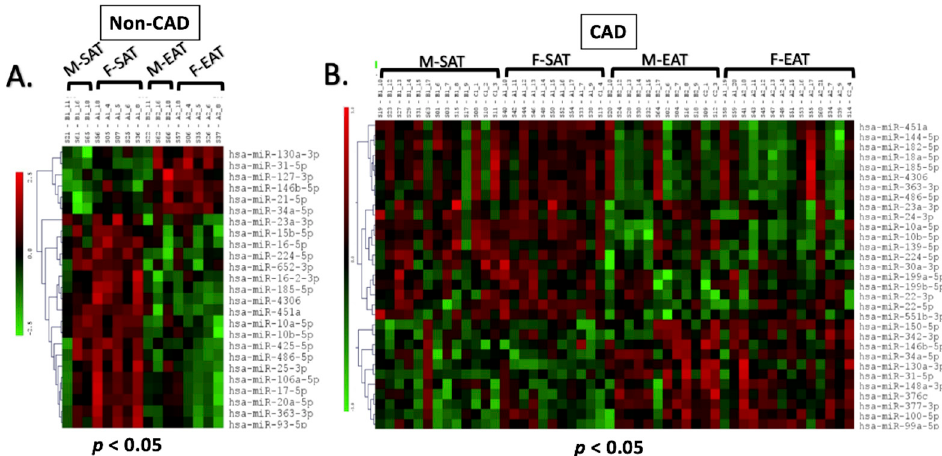
Figure 1. Heatmap of differentially expressed miRNAs between epicardial and subcutaneous adipose tissue samples from patients with and without CAD: microRNA microarray on EAT and SAT samples from both males and females were analyzed and compared. The heatmap (LC Sciences, Houston, TX, USA) displayed shows differentially expressed microRNAs between EAT and SAT in non-CAD patients ( A ) and CAD patients ( B ). Differential analysis was first performed using ANOVA to produce a miRNA expression profile overview across all samples. This was followed by t -tests p < 0.05, to identify significantly differentiated miRNAs between EAT and SAT in patients with and without CAD.